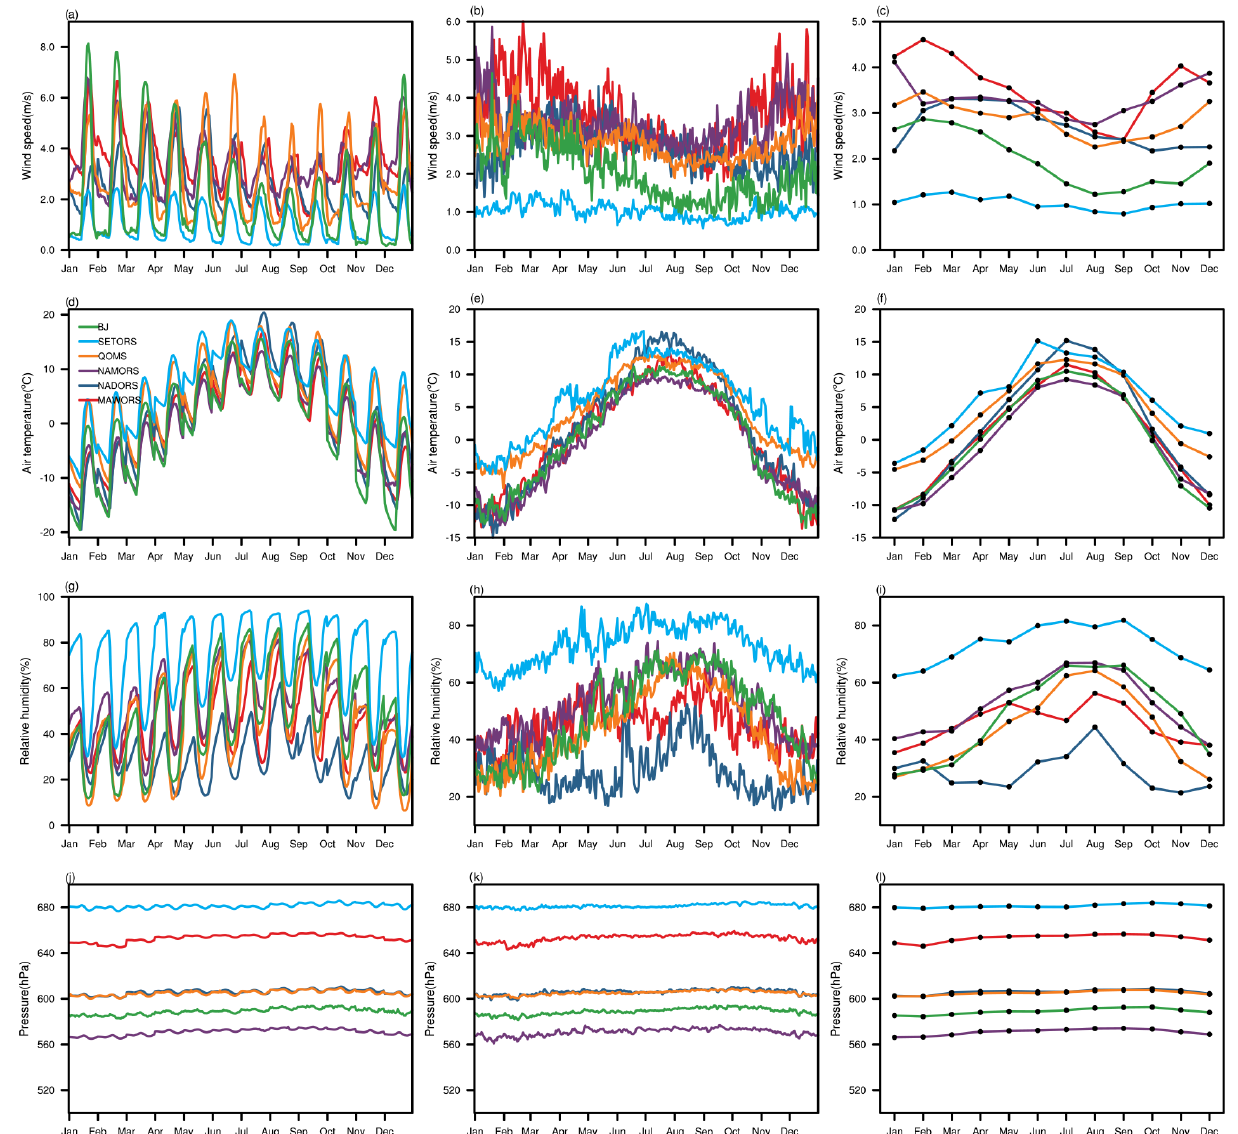
Figure 2. The climatological averages of the lowest level of wind speed, air temperature, relative humidity and surface pressure at diurnal (left), daily (middle) and monthly (right) scales. For sites except BJ, the climatological mean of each variable was calculated based on all the available observations; for BJ, only the observations during the period of 2006–2014 were